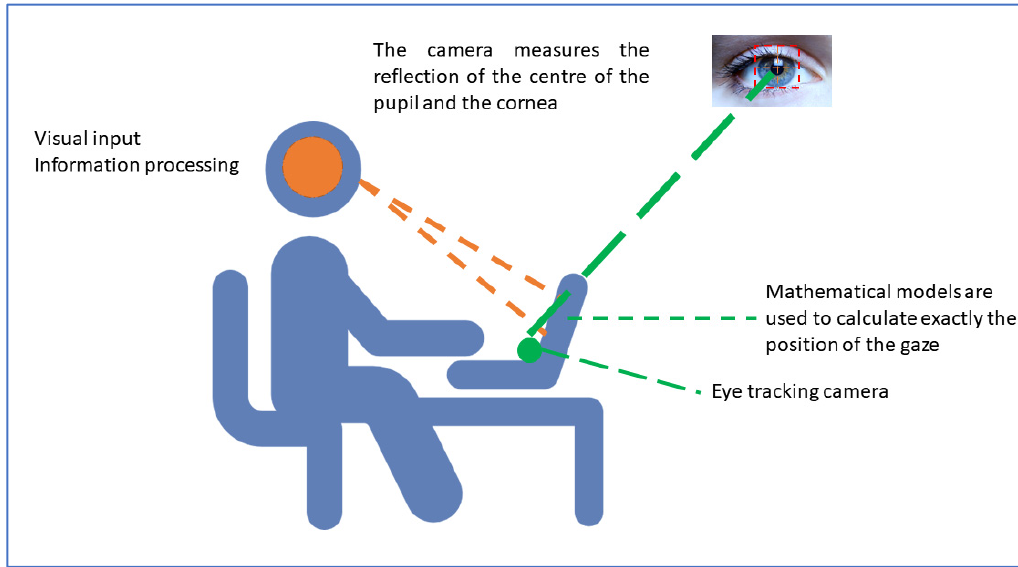
Figure 3. Visual tracking process during the resolution of a task.